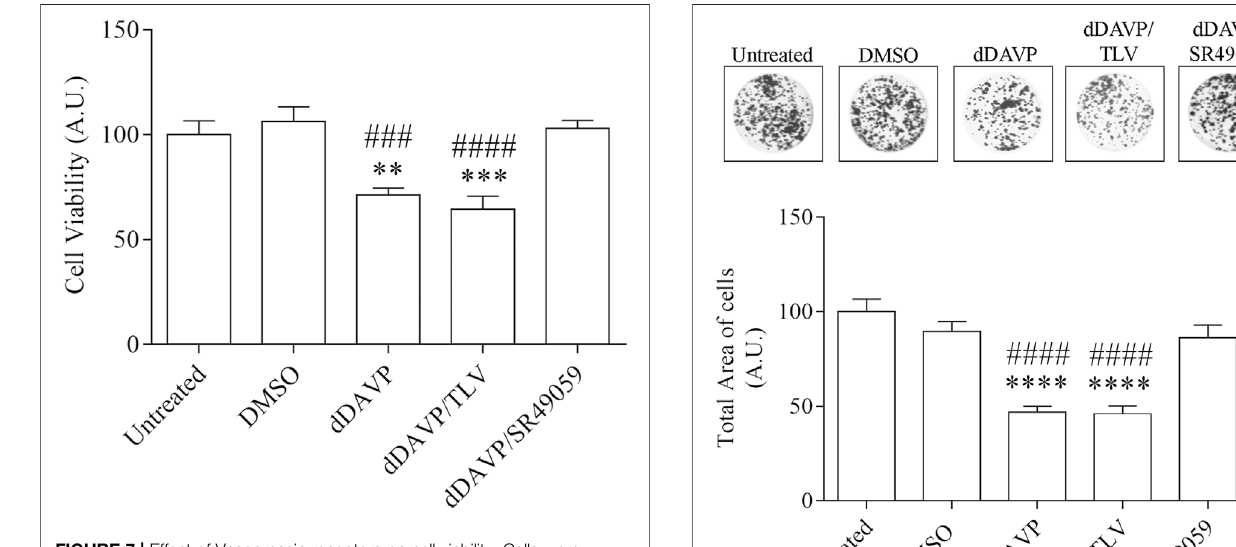
FIGURE 7 | Effect of Vasopressin receptors on cell viability. Cells were leftunderbasalconditionsortreatedasdescribedinthemethods sectionand were stained with crystal violet solution. Treatment with 100 nM dDAVP signi fi cantly reduced cell viability compared with untreated cells. The same effect was observed in cells treated with 100 nM dDAVP and 100 nM tolvaptan for 72 h. In contrast, stimulation with 100 nM SR49059 did not affect dDAVP cell viability. Data are presented as means ± S.E.M. of six independent experiment and analyzed by one-way ANOVA followed by Dunnett ’ sMultipleComparisontest(** p < 0.01and*** p < 0.001vs.untreated; ### p < 0.001 and #### p < 0.0001 vs. DMSO).